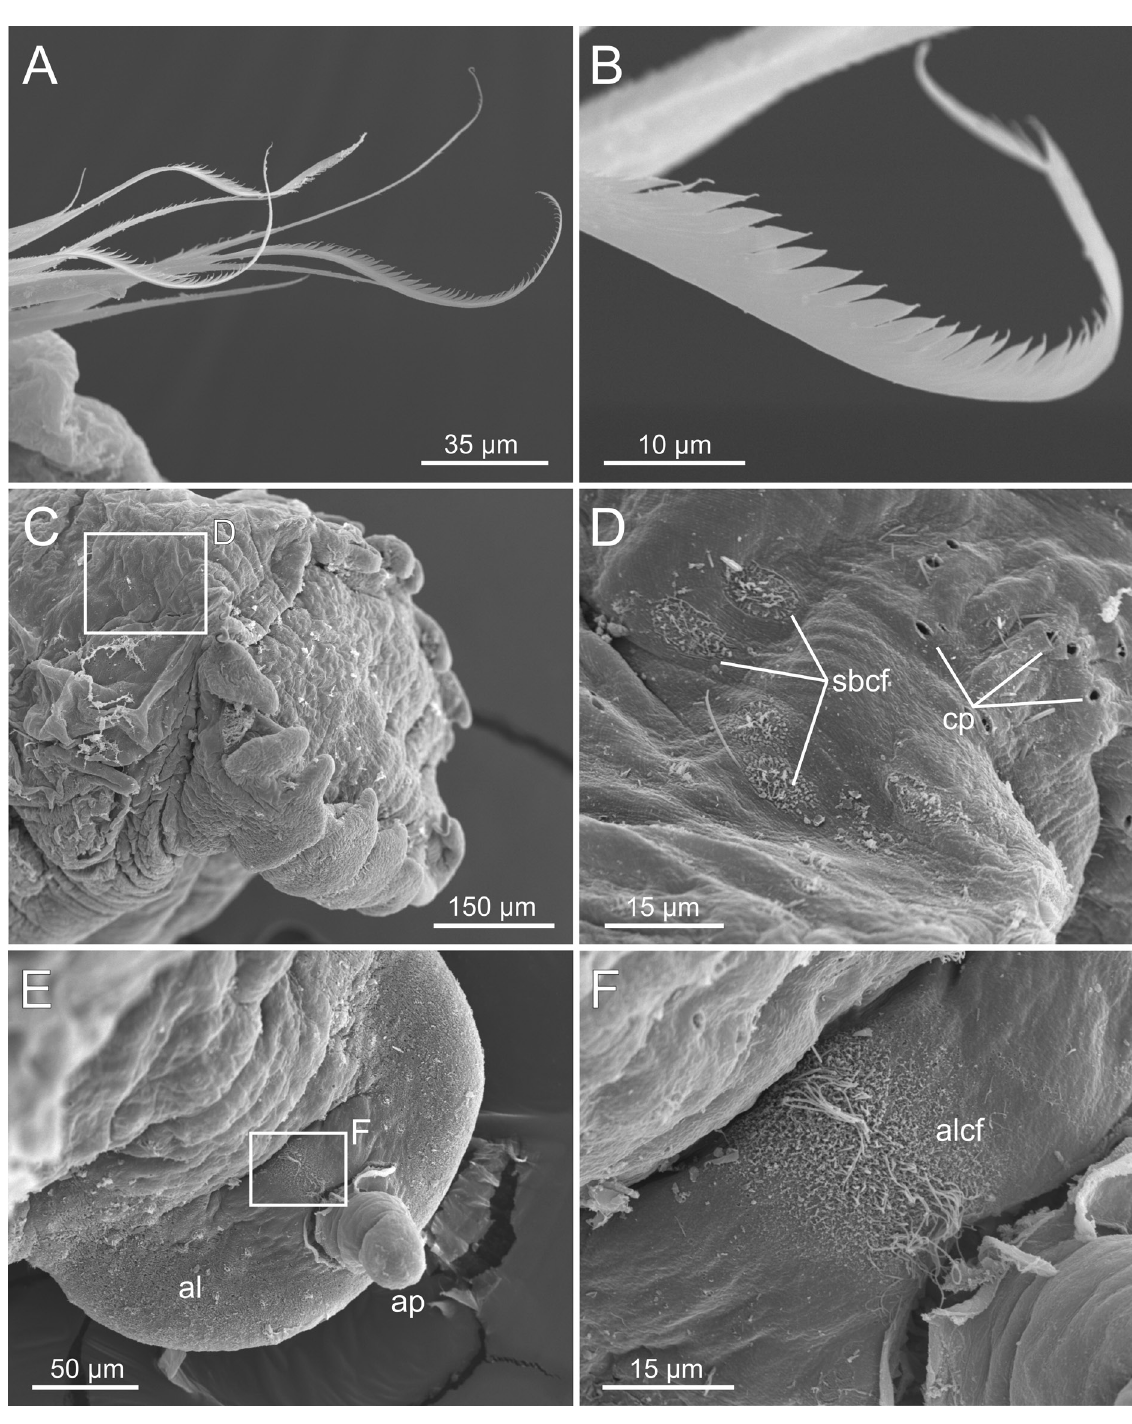
Fig. 15. Cistenides hyperborea Malmgren, 1866. SEM micrographs from two medium-sized specimens (BIOICE sample 2060, IINH-40471). A . Mid-body parapodium, notochaetae. B . Notochaeta, serrated distal end, detail. C . Scaphe, dorso-lateral view. D . Cuticular structures (framed in C). E . Anal lobe and anal papilla. F . Ciliary field dorsal to anal lobe (framed in